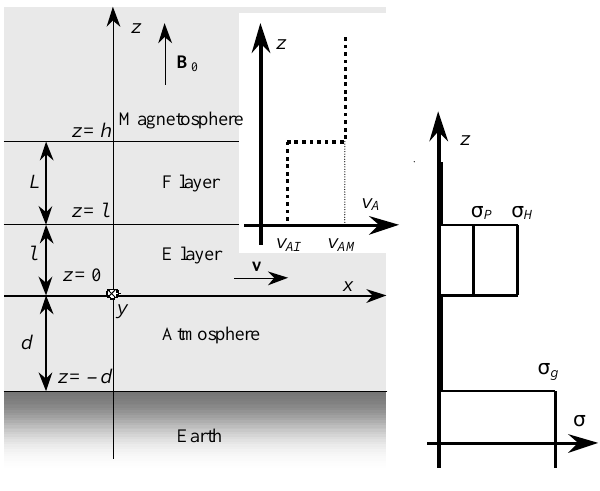
Fig. 1. A schematic drawing of a stratified medium model. The plots of the Alfv´en velocity and the ionosphere/ground conductivi- ties are shown in the right